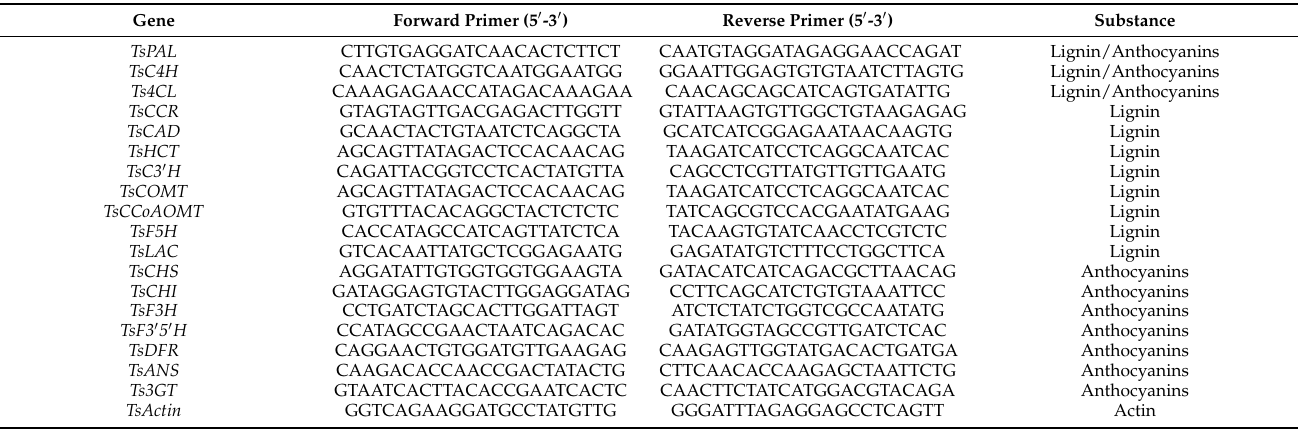
Table 1. Primers for RT-qPCR related to anthocyanins and lignin synthesis. Gene Forward Primer (5 (cid:48) -3 (cid:48) ) Reverse Primer (5 (cid:48) -3 (cid:48) ) Substance